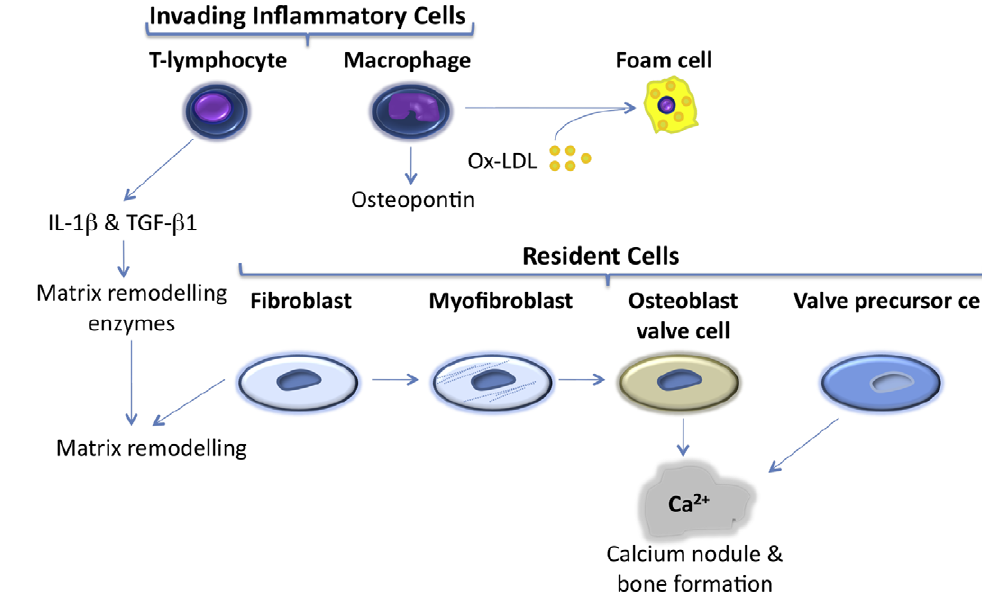
Figure. 4 Schematic representation of the cells that participate in the formation of calcified lesions in heart